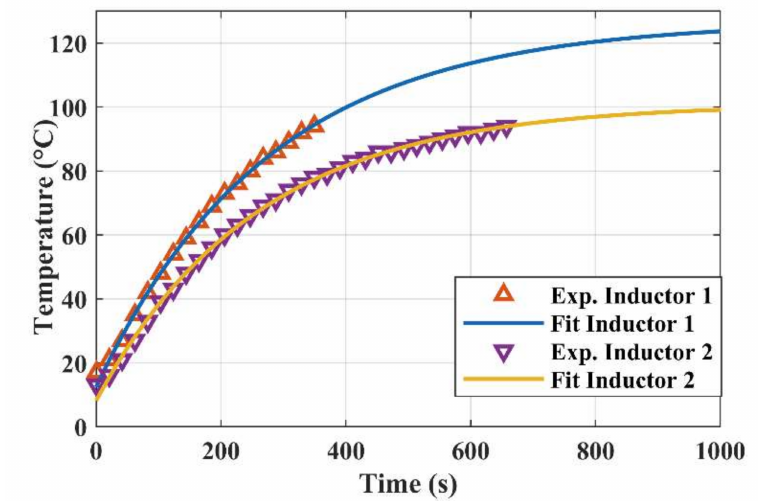
Figure 9. Thermal transient for inductor 1 (blue) and inductor 2